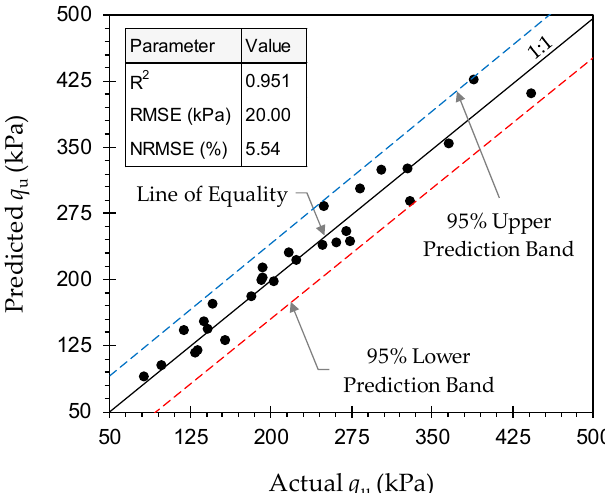
Figure 11. Variations of predicted, by Equation (11), against actual peak UC strength data for various JF + GBFS blends.